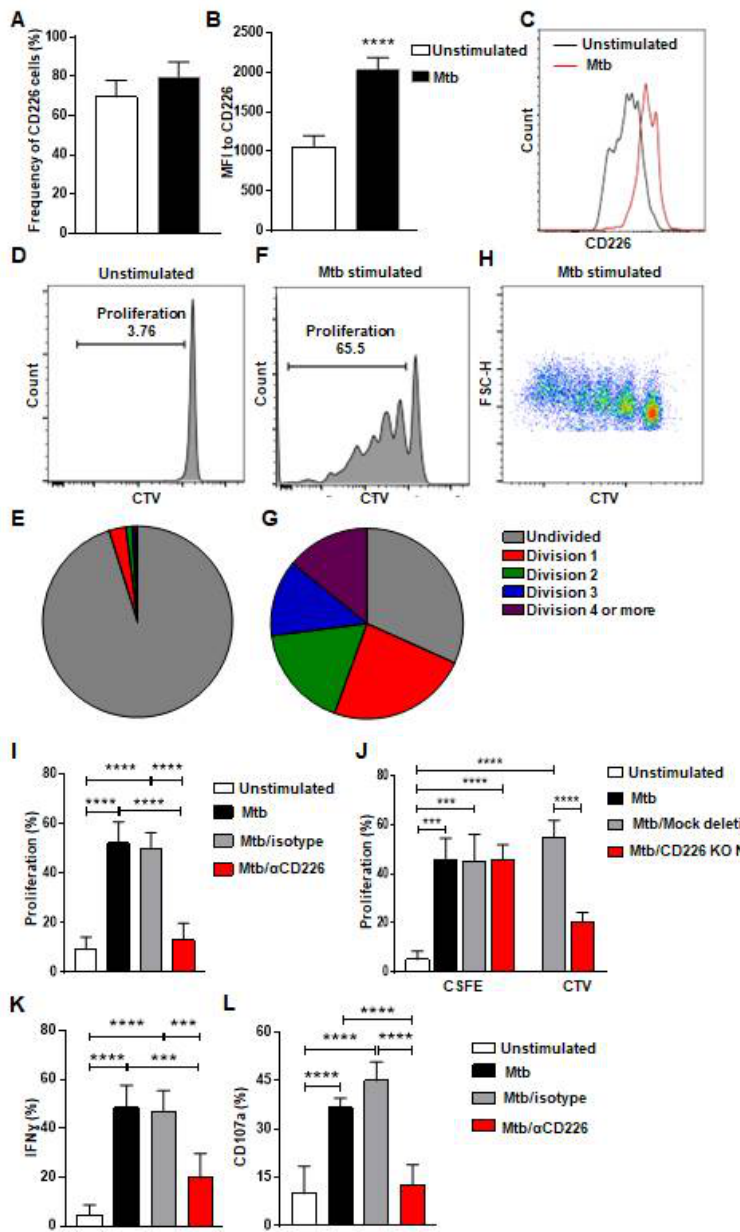
Figure 1. CD226 blockade reduces proliferation by mlNKs from LTBI+ people after stimulation with Mtb. ( A ) Frequency of CD226+ cells in CD3 − CD45+CD56+CD27+ cells (n = 5). ( B ) MFI of CD226 in CD3 − CD45+CD56+CD27+ cells (n = 5), ( C ) Comparative histogram. ( D – G ) Unstimulated CD3 − CD45+CD56+CD27+ cells ( D , E ) CD3 − CD45+CD56+CD27+ cells ( F – H ) were stimulated with γ -Mtb for 5 days. Pie charts show number of divisions in unstimulated ( E ) and stimulated cells ( G ). ( H ) Pseudo color plot showing the number of divisions in CD3 − CD45+CD56+CD27+ cells stimulated with γ -irradiated Mtb. ( I ) Proliferation percentage in CD3 − CD45+CD56+CD27+ cells unstimulated or stimulated with γ -Mtb or stimulated with treatments of control isotype or blocking CD226 antibody (n = 7). ( J ) Proliferation of CD3 − CD45+CD56+ cells not deleted or deleted for CD226 gene using CRISPR/Cas9 stained with cell trace violet (CTV) and co-cultured with autologous PBMC stained with CFSE and stimulated with γ -Mtb (n = 6). ( K ) IFN- γ , ( L ) CD107a positive cells in CD3 − CD45+CD56+CD27+ cells unstimulated or stimulated with γ -Mtb or stimulated and treated with control isotype or blocking CD226 antibody (n = 5). Mean ± s.d. two-sided Student’s t -test or ANOVA. *** p < 0.001, **** p <